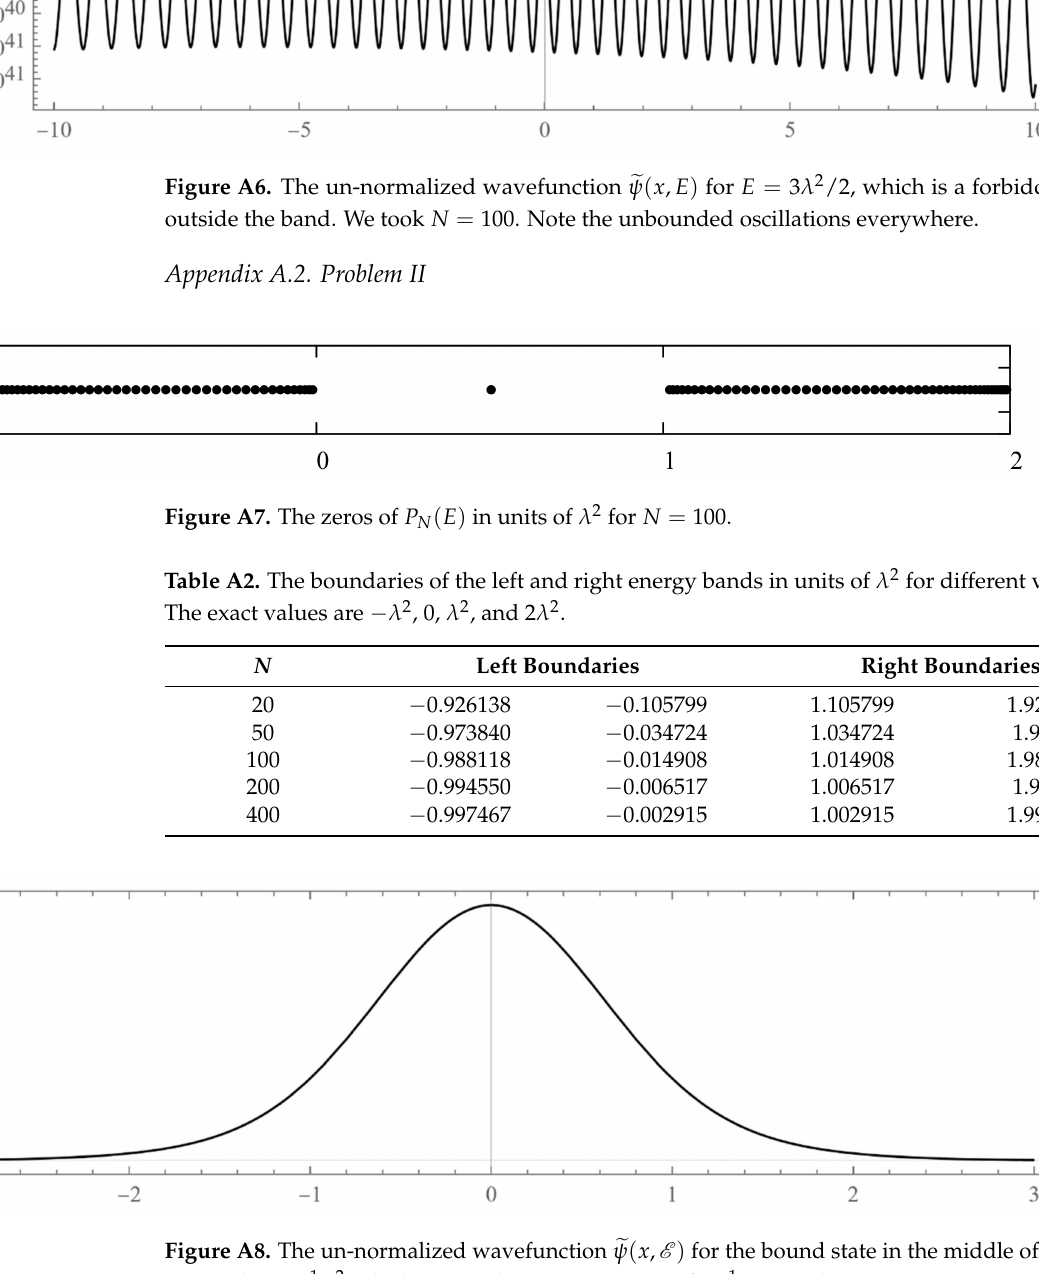
Figure A8. The un-normalized wavefunction (cid:101) ψ ( x , E ) for the bound state in the middle of the energy λ 2 . The horizontal x -axis is in units of λ − 1 . We took N = gap with E = 1 2